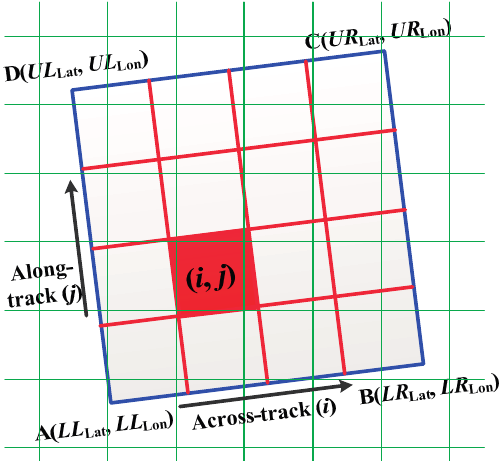
imaging pixel is divided into 4 × 4 sub-pixels (red grid). In the interpolation-resampling process, the oversampled input data (green grid) is resampled into not the imaging pixels (blue grid) but the